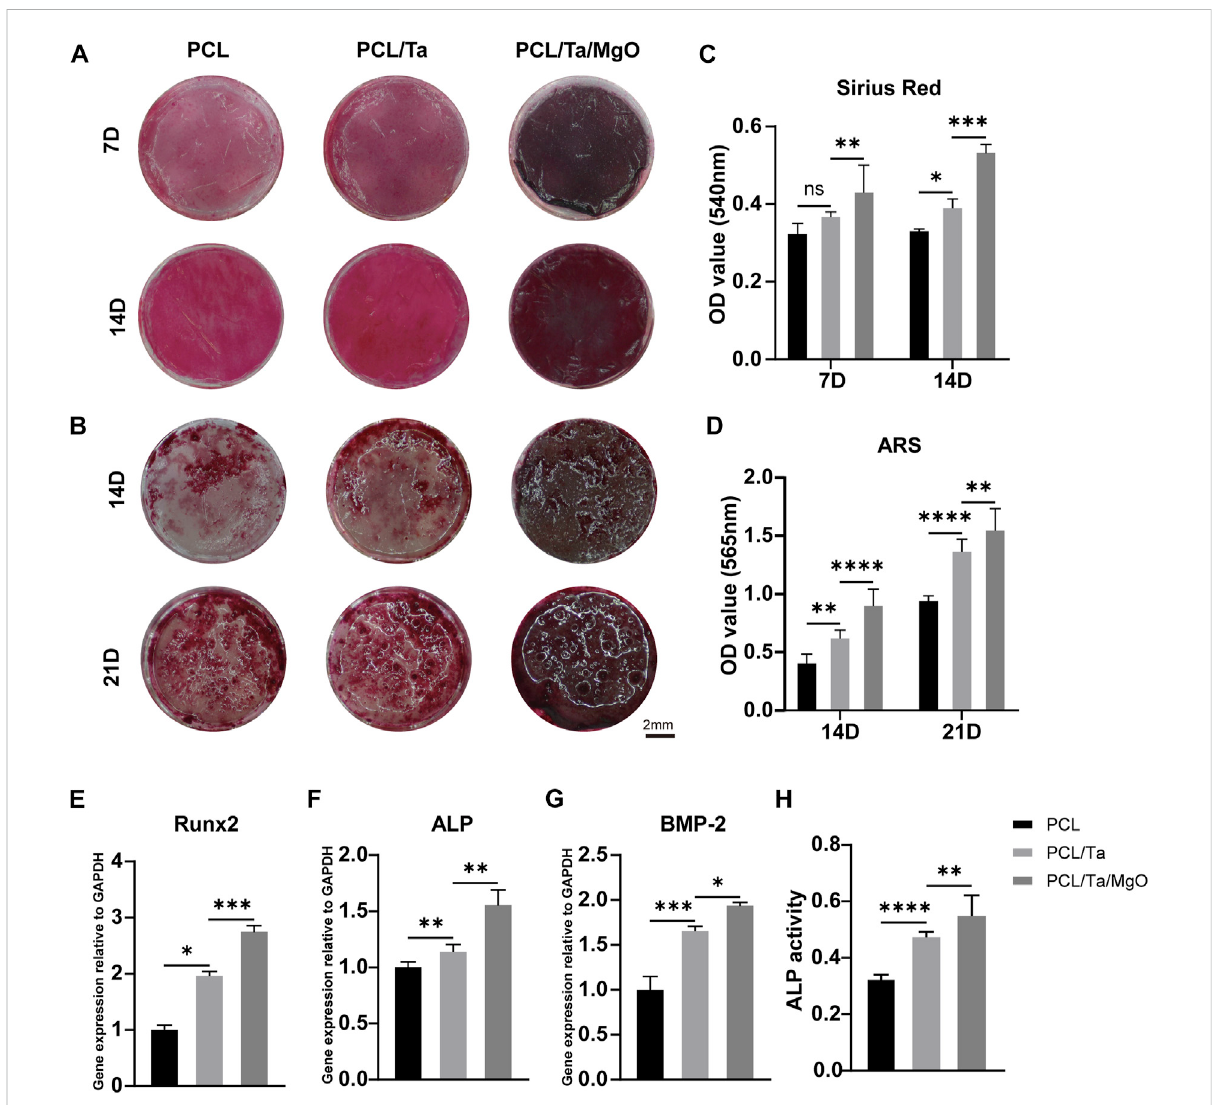
FIGURE 4 Evaluation of the in vitro osteogenic differentiation of BMSCs on different membranes. (A) Representative images of Sirius red staining on days 7 and 14 after osteogenic induction and (B) Alizarin red S (ARS) staining on days 14 and 21. Semi-quantitative analysis of (C) Sirius red and (D) ARS staining ( n = 6). Gene expression levels of osteogenesis-related factors (E) Runx2, (F) ALP, and (G) BMP-2 genes in BMSCs on day 7 ( n = 3). (H) ALP activity by BMSCs on different membranes. ( n = 6) (* p < 0.05, ** p < 0.01, *** p < 0.001, and **** p <